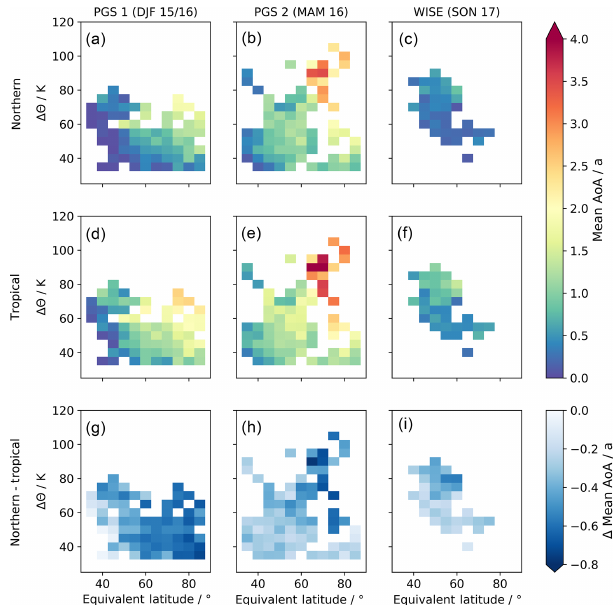
Figure 6. Cross sections of binned mean age of air calculated using the age spectra retrieved with the inverse method in the Monte Carlo simulation (see Sect. 2.2.4). The top row shows mean AoA referring to the northern hemispheric tropopause section, while mean AoA in the middle row refers to the tropical tropopause section. The left column displays data of PGS phase 1, middle column data of PGS phase 2, and right column data of WISE. The bottom row gives the absolute differences between the data in the top and middle rows. The potential temperature difference to the local tropopause (cid:49)(cid:50) is used as the vertical coordinate and equivalent latitude as the hori- zontal